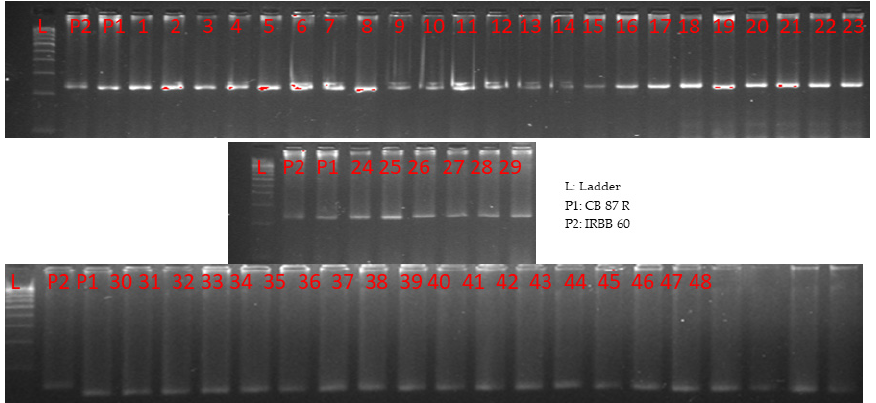
Figure 1. Identification of xa5 bacterial blight resistance gene in BC1F1 cross of CB 87 R × (CB 87 R × IRBB 60).